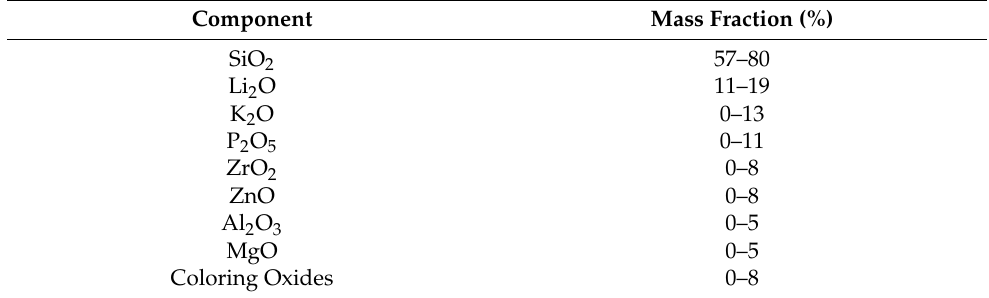
Table 2. Chemical composition of the cast blanks.